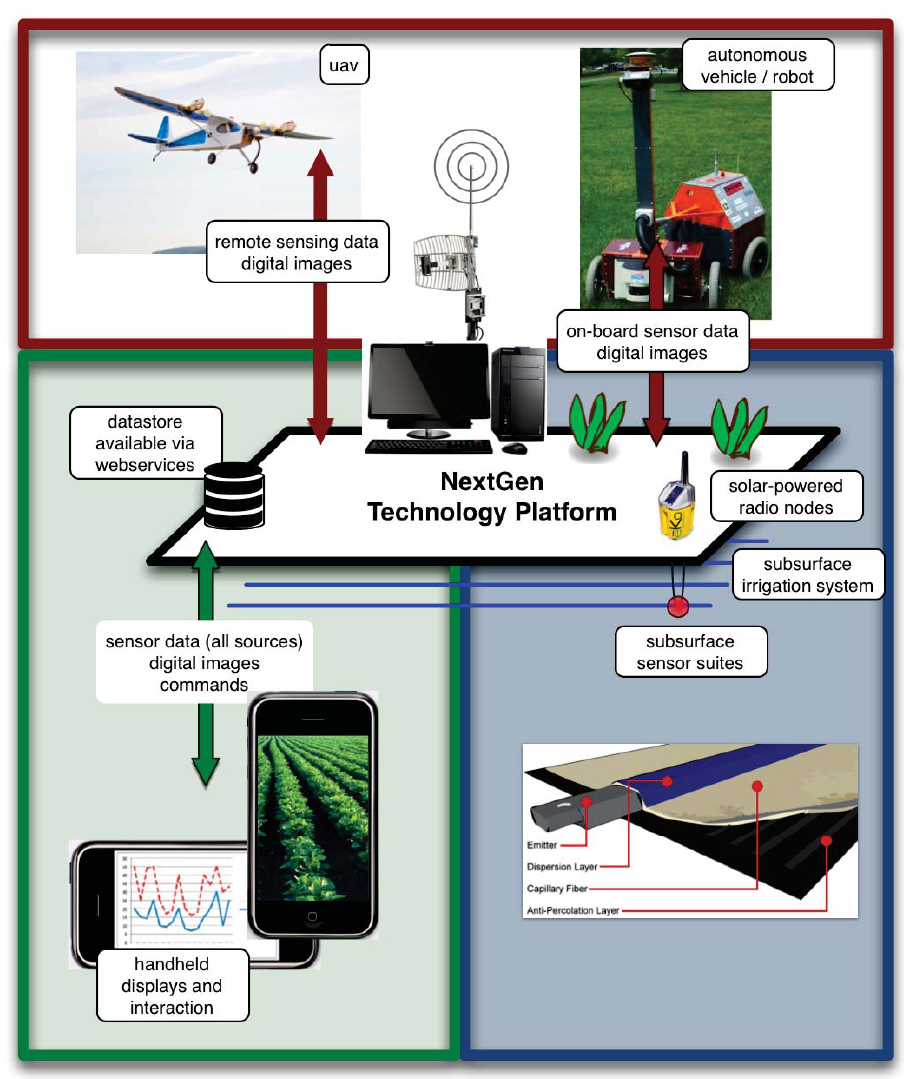
Figure 1. The interacting components of the next-generation, sustainable agriculture technology platform. Research in the green area addresses information flow, accessibility, and areas of human-computer interaction. Research in the blue areas represent advanced agricultural irrigation practices [190]. The red areas represent engineering opportunities to integrate unmanned vehicles in support of data collection, monitoring and